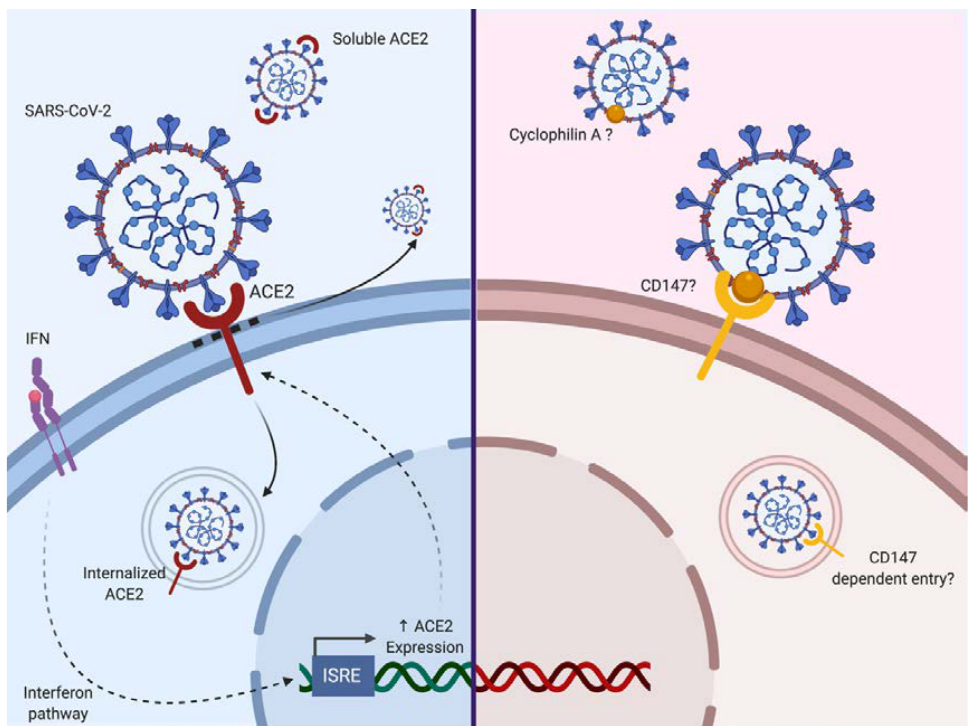
Figure 2. The two evoked routes of entry for SARS-CoV-2 to date. Angiotensin-converting-enzyme 2 (ACE2), which has been described as an interferon-stimulated gene (ISG), is a route of entry for SARS-CoV-2. Additionally, CD147 is evoked as a potential second route of entry. Based on a previous study with SARS-CoV, an interaction with Cyclophilin A is possible. The blue background corresponds to cells expressing ACE2, whereas the red background is representing cells expressing CD147. Solid arrows correspond to a direct activity involving ACE2, dotted arrows correspond to an indirect promoting activity.